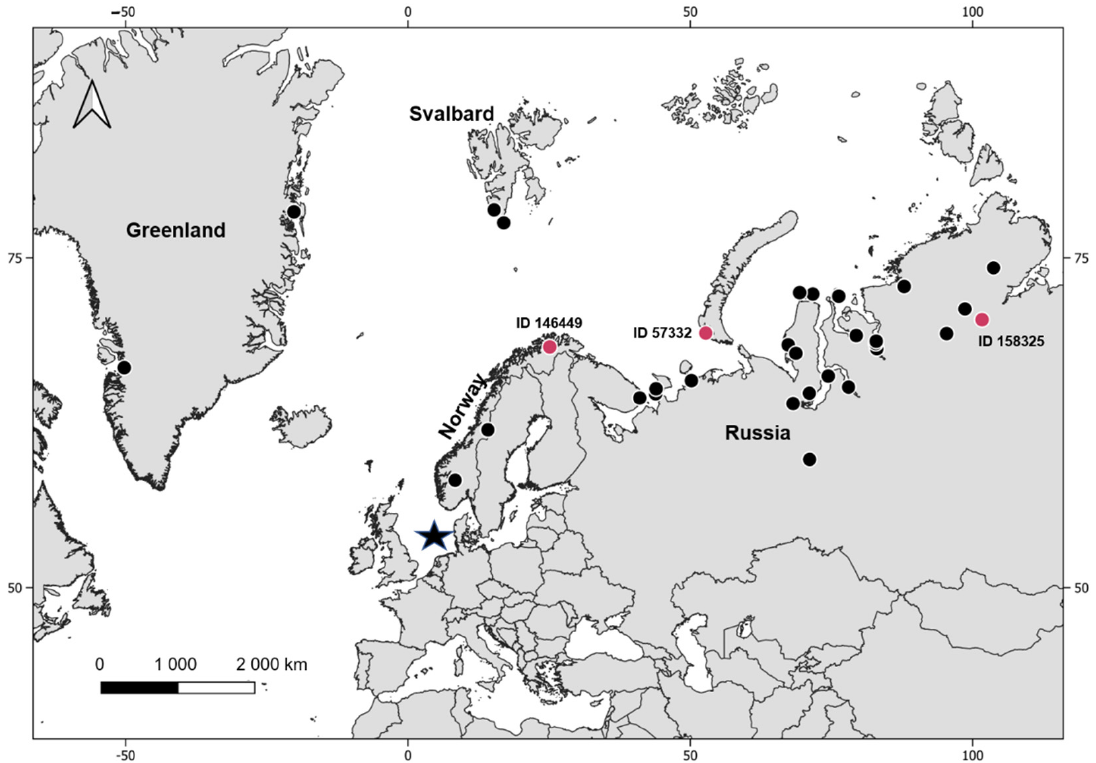
Figure 2. Overview of the breeding locations of the sampled red-throated divers. The capture area (sample location) is indicated by a black star, breeding locations of not infected individuals are indicated by black dots and breeding locations of infected individuals where a breeding location could have been assigned are indicated by red dots.